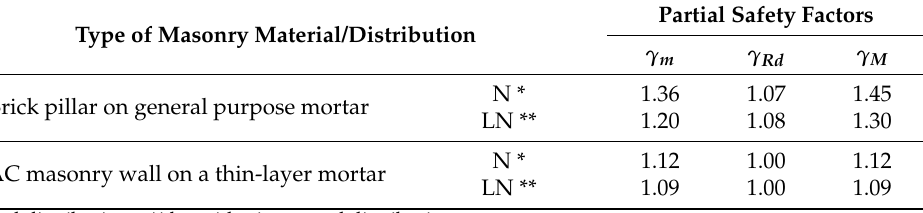
Table 8. Values of partial safety factors of the analyzed masonry structures determined for the RC2 reliability class and the 50-year reference